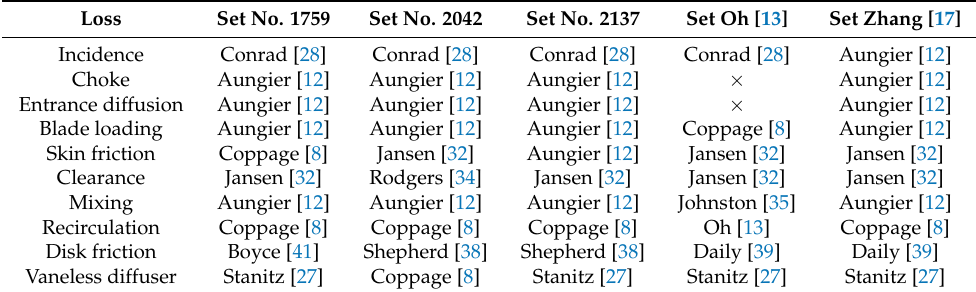
Table 3. Breakdown of individual loss models for candidate loss model